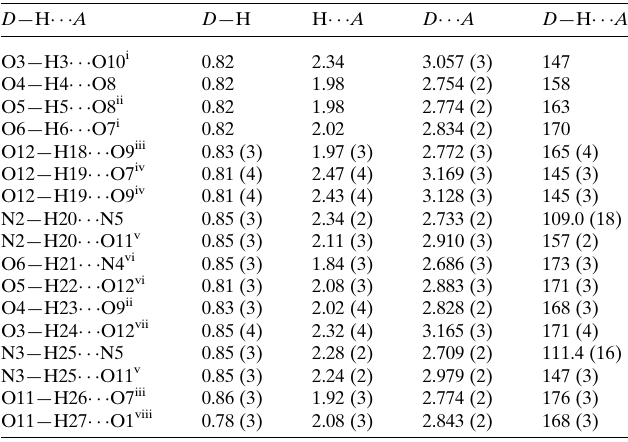
Table 3 Hydrogen-bond geometry (A˚ , (cid:3) ) for (I).